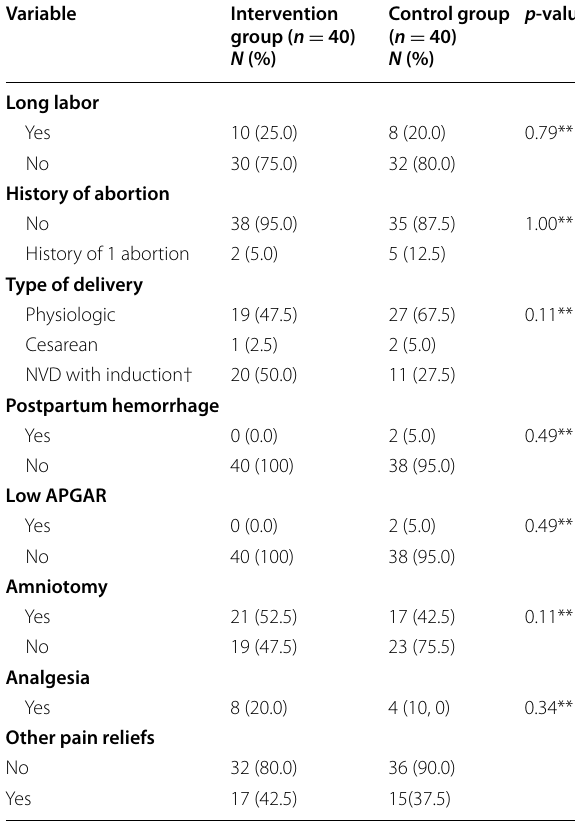
the intervention, the mean (SD) of professional support sub-scale in the intervention group (42.99 (0.71)) was significantly higher than that in the control group (38.6 (Table 2).